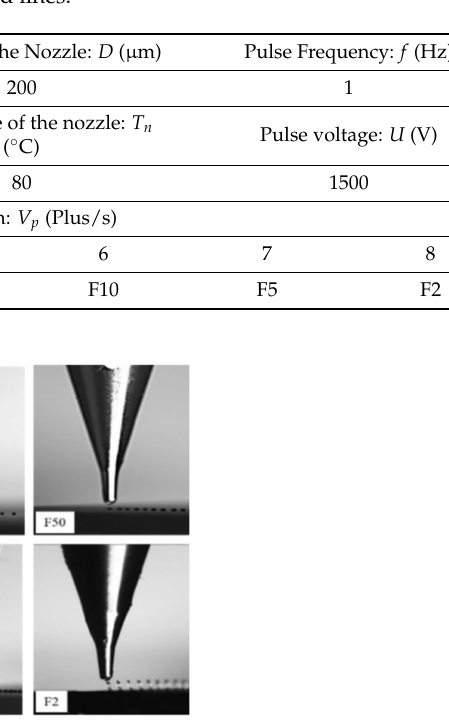
Figure 9. Image of droplets deposition process at different velocities in horizontal direction.